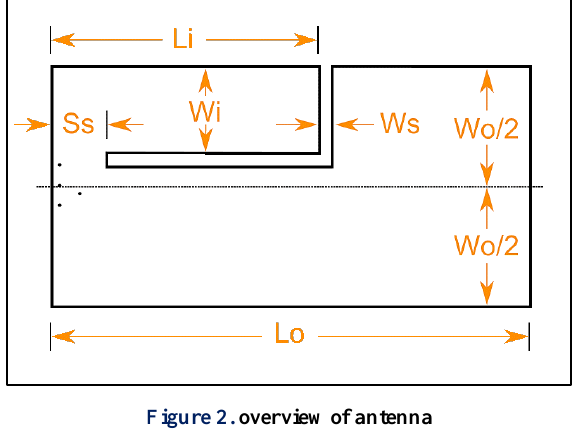
Figure 2. overview of antenna